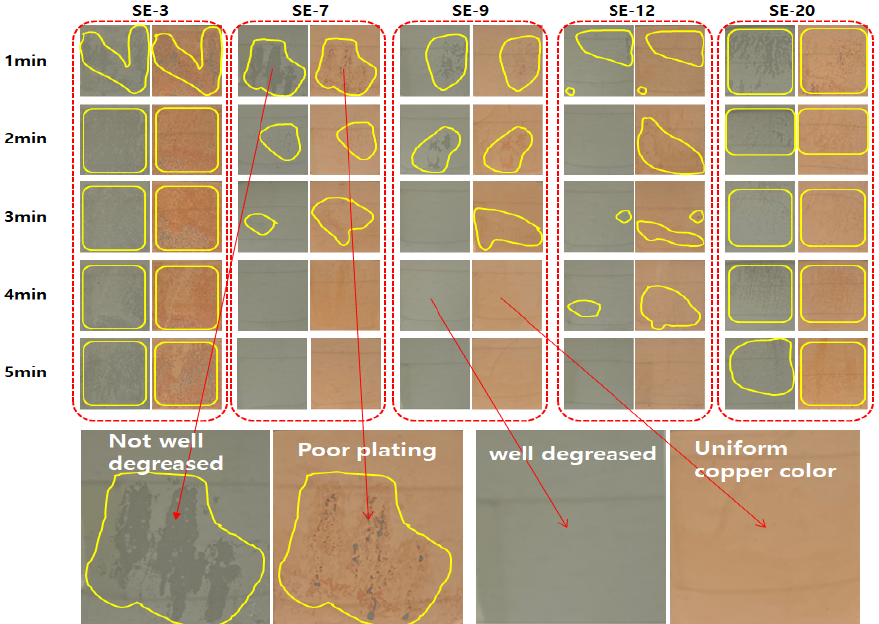
Figure 4. Images of the degreased specimens before ( left ) and after ( right ) the Hogaboom tests as a function of degreasing time at 40 °C.